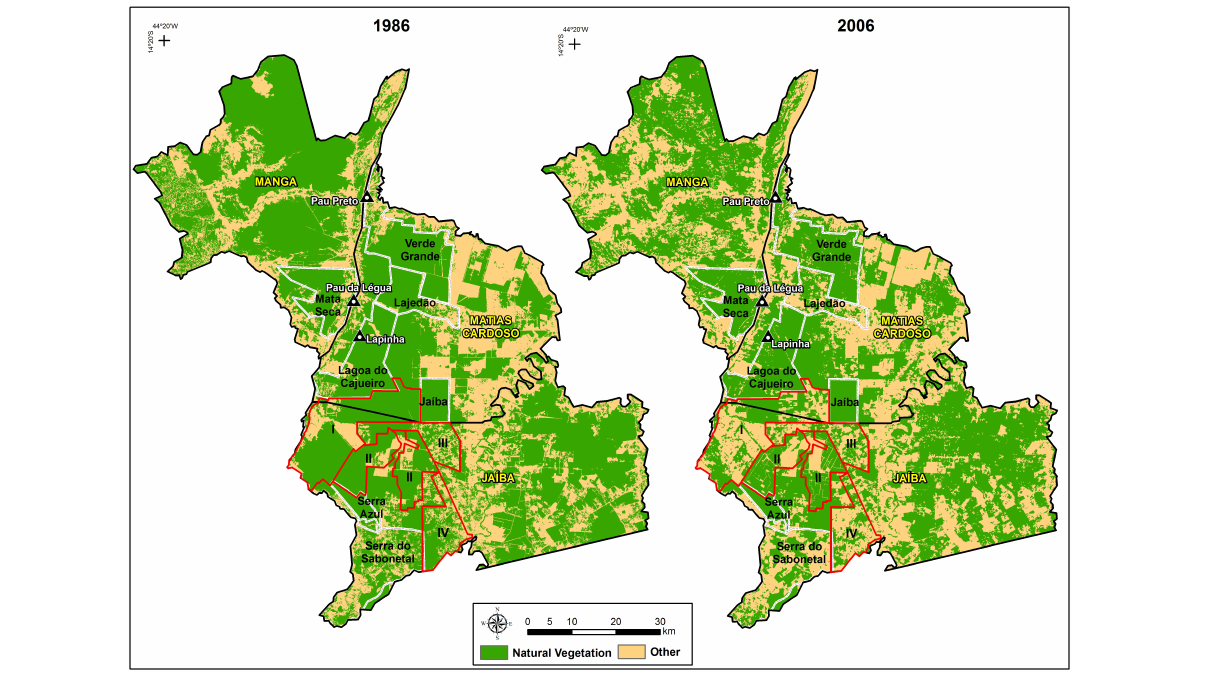
Fig. 3 . Land cover change in the study region (municipalities of Manga, Matias Cardoso and Jaíba) from 1986 to 2006. The only protected area (PA) that existed in 1986 is the Jaíba Biological Reserve (Jaíba). Limits of PAs are shown in white and limits of the four phases of the Jaíba Project are shown in